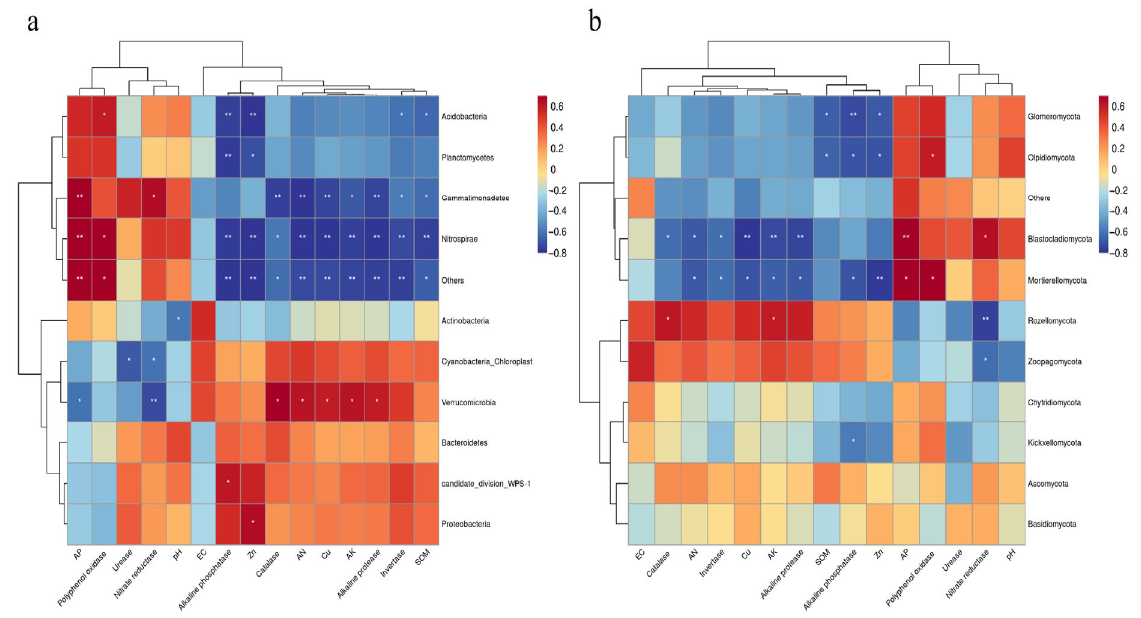
Figure 6. Heat map analysis of the correlation of bacterial ( a ) and fungal ( b ) communities with soil physicochemical enzyme activity. SOM, soil organic matter; Cu, copper; Zn, zinc; EC, electrical conductivity; AN, available nitrogen; AP, available phosphorus; AK, available potassium. * p < 0.05; ** p < 0.01.